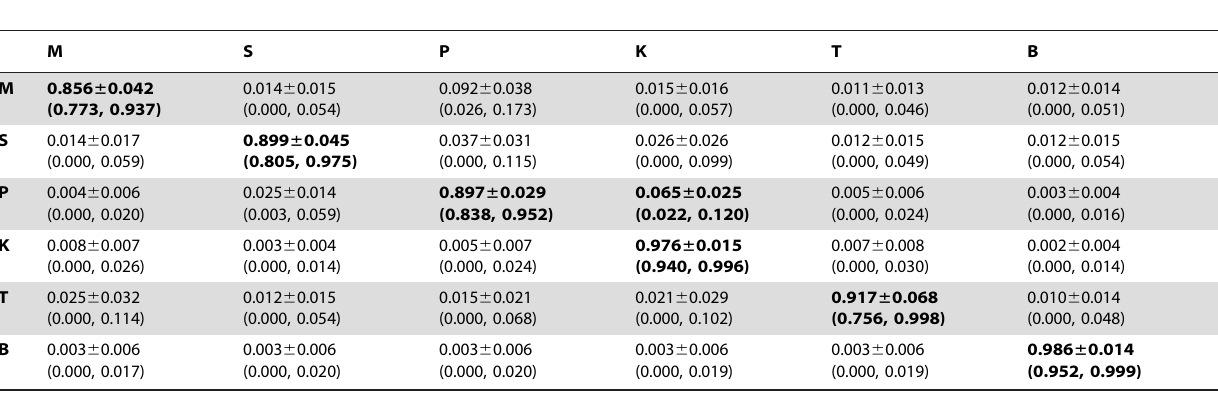
Table 4. Locality-wise contemporary migration rates, m , estimated using BAYESASS, showing means ( 6 standard deviation) of the posterior distributions along with the 95% confidence intervals in